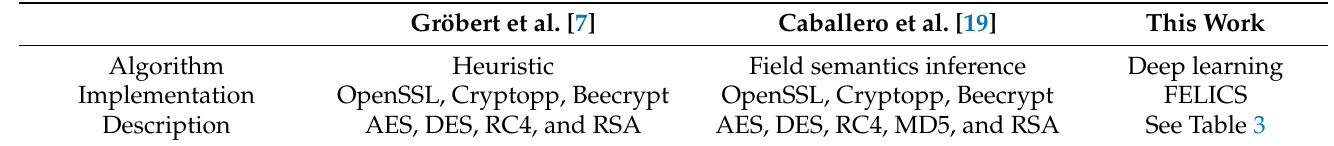
Table 10. Comparison with other